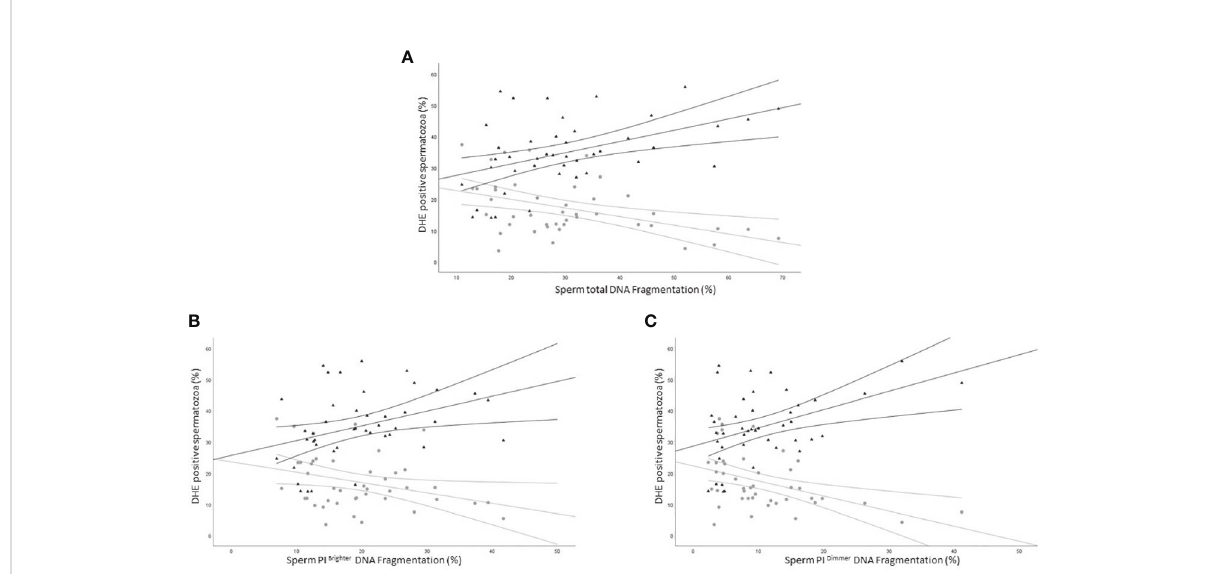
FIGURE 7 Scatter plots representing the relationship between the percentage of DHE viable (grey circles) and unviable (black triangles) positive spermatozoa and total ( A , viable: R=-0.4, p<0.05; unviable: R=0.5, p<0.01), PI brighter ( B , viable: R=-0.3, p=ns; unviable: R=0.4, p<0.01) and PI dimmer ( C , viable: R=-0.4, p<0.01; unviable: R=0.3, p<0.05) DNA fragmentation in 43